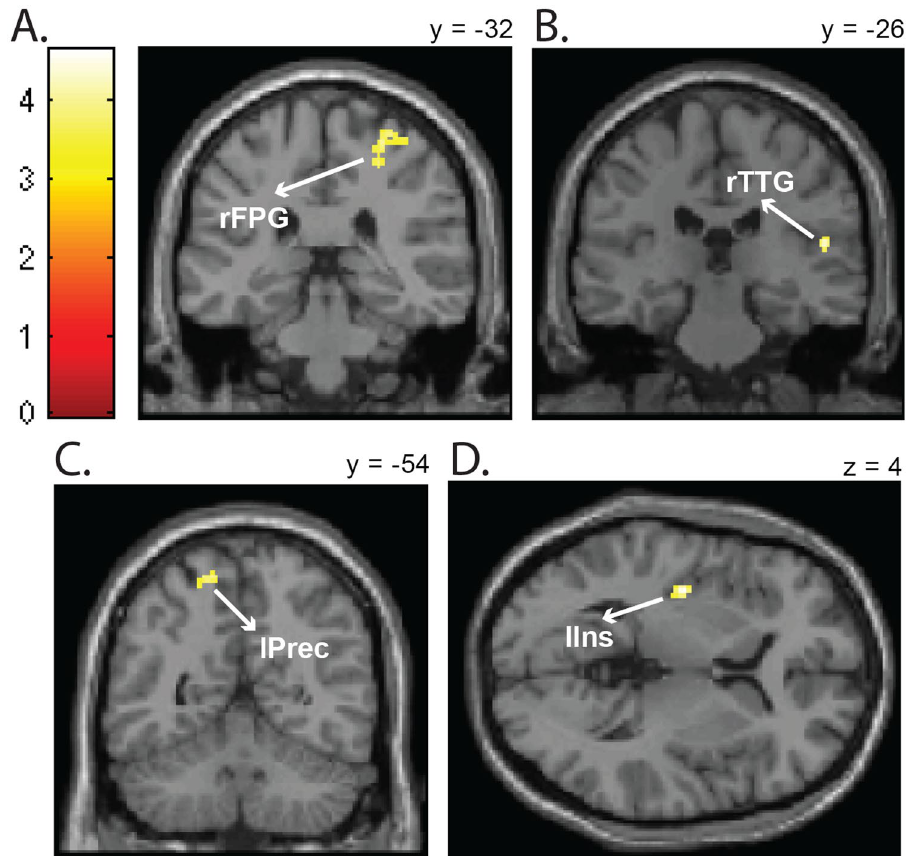
Figure 4. Emotional vs. neutral stimuli influence in the binding. Brain areas significantly ( p < 0.001, cluster corrected at p < 0.05) more activated for a complete repetition of emotional than neutral faces when the motor response is also repeated, as shown by the same response + sameemotion > same response + sameneut t-contrast. ( A ) Activation of the right frontal precentral gyrus (rFPG). ( B ) Activation of the right transverse temporal gyrus (rTTG). ( C ) Activation of the left precuneus (lPrec). ( D ) Activation of the left insula